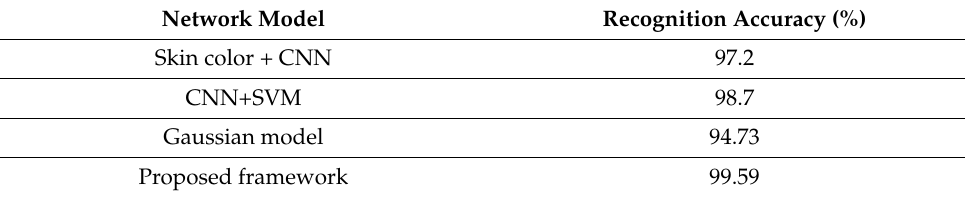
Table 4. Recognition accuracy of different algorithms on the Marcel